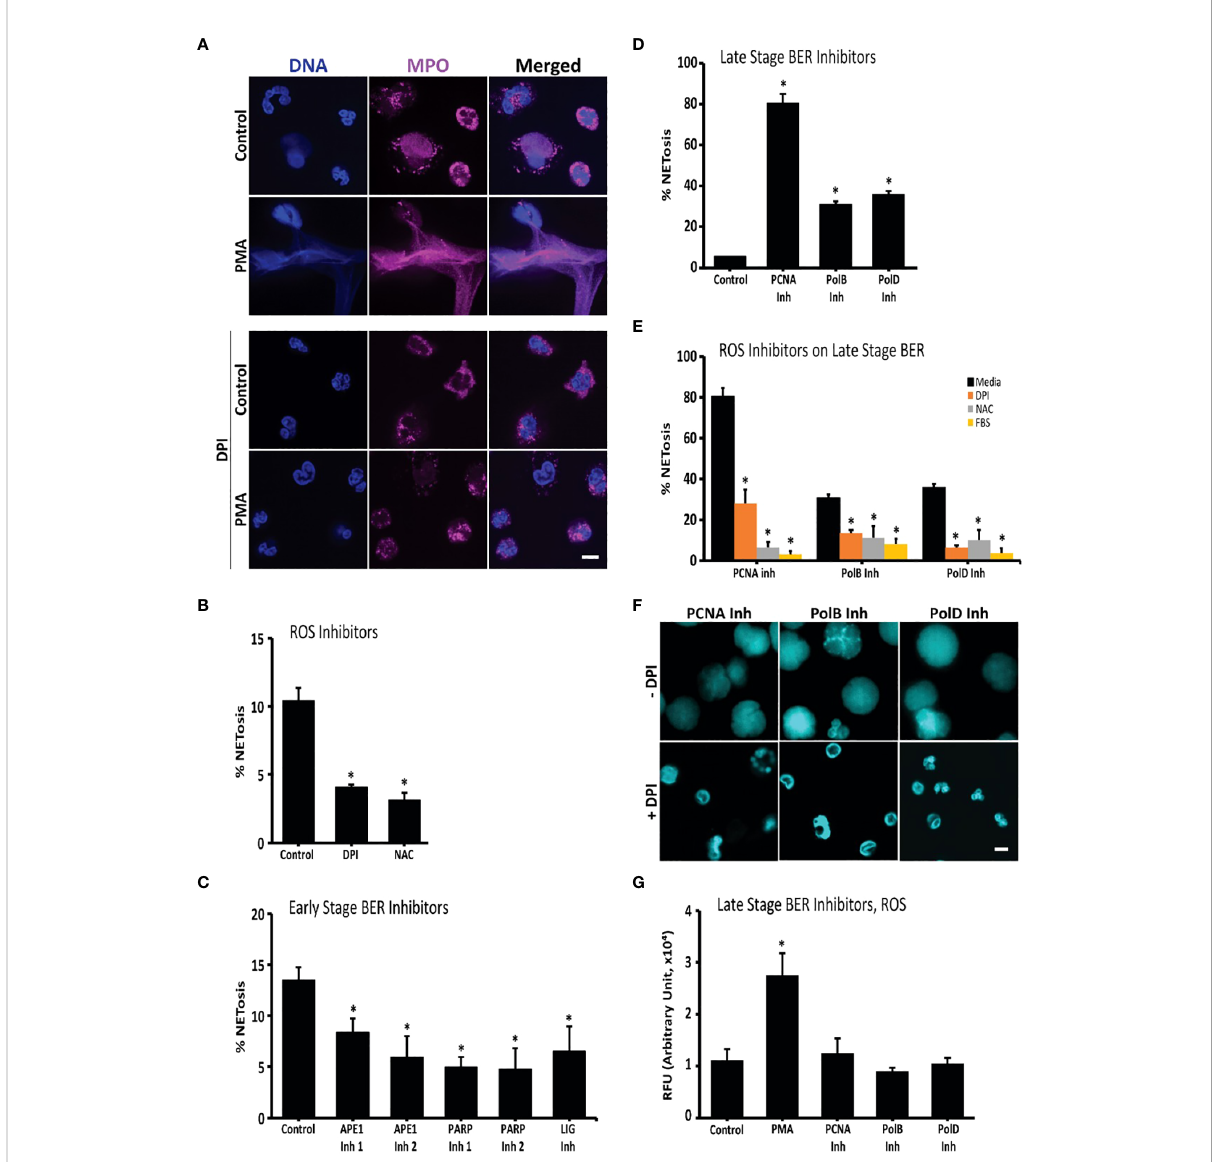
FIGURE 1 Oxidative DNA damage and repair drive NETosis: inhibition of early repair steps suppresses spontaneous NETosis while inhibition of late repair steps promotes it. (A) Immunoconfocal imaging con fi rms that neutrophils undergo low level spontaneous NETosis in media, while PMA, an oxidative burst inducer, promotes robust NETosis. Presence of DPI, an inhibitor of ROS generation, suppresses NETosis in both experimental conditions. DNA (DAPI, blue), MPO (pink). (B) NET DNA release from neutrophils incubated in media, or media with DPI or NAC indicates that ROS inhibitors suppress spontaneous NETosis (SYTOX; *, p<0.05 compared to control). (C) DNA release from neutrophils incubated in media or media with inhibitors (inh) of early stage oxidative DNA damage repair proteins APE (inh 1 or 2), PARP1 (inh 1 or 2) or LIG suggests that inhibition of these proteins suppresses spontaneous NETosis (SYTOX; *, p<0.05 compared to control). (D) DNA release from neutrophils incubated in media, or media with inhibitors of late stage repair proteins PCNA, Pol b or Pol d suggest that inhibition of these proteins promotes spontaneous NETosis (SYTOX; *, p<0.05 compared to control). (E) DNA release from neutrophils incubated with ROS inhibitors (DPI, NAC or FBS) shows that spontaneous NETosis is suppressed by ROS inhibitors regardless of the presence of inhibitors to PCNA, Pol b or Pol d in the media (SYTOX; *, p<0.05 compared to media treated control in each respective cluster). (F) Confocal imaging con fi rms that ROS inhibitor DPI suppresses spontaneous NETosis promoted by the inhibitors of PCNA, Pol b or Pol d . DNA (DAPI, blue). (G) ROS measurements by DHR123 assays show that neutrophils used in the experiments generate high levels of ROS when stimulated with PMA (+ve control) compared to non-activated neutrophils. Presence of inhibitors to PCNA, Pol b or Pol d does not alter the baseline ROS generation (Plate reader; *, p<0.05 compared to control). Serum was not added to the media unless otherwise stated. DNA repair inhibitors used were: APE inh 1 (CRT0044876), APE inh 2 (APE1 Inhibitor III), PARP1 inh 1 (BSI201), PARP inh 2 (PJ34) or LIG inh (L189), PCNA inh (T2AA), Pol b inh (AM-TS23) or Pol d inh (Aphidicolin). Fluorescence was recorded at 4-hour time points by SYTOX Green plate reader assays (n = 3 for all the experiments). The images are representative of 3 independent experiments, at 4-hour time points. Scale bar on images, 5 m